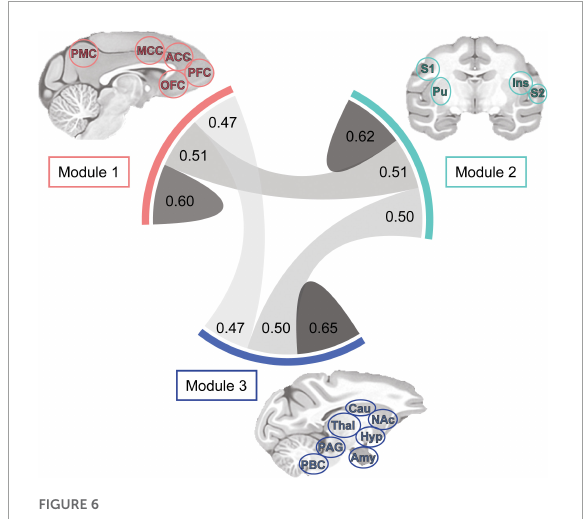
FIGURE6 Tri-modular connectome and connection strength within and between sub-networks. Each module includes a unique set of regions and all modules exhibited bilaterality, indicating inclusion of region nodes in the left and right hemispheres. Chord diagram showing the correlation strength between bilateral regions of Modules 1 ( n = 8), 2 ( n = 12), and 3 ( n = 9). Connection line thickness and darkness represent correlation strength. Note the difference in connection strength ( r -value) between and within Modules: 1-1, 0.60; 1-2, 0.51; 1-3, 0.47; 2-2, 0.62; 2-3, 0.50; 3-3, 0.65. ACC, anterior cingulate cortex; Amy, amygdala; Cau, caudate; Hyp, hypothalamus; Ins, insula; NAc, nucleus accumbens; MCC, mid-cingulate cortex; OFC, orbitofrontal cortex; PAG, periaqueductal gray; PBC, parabrachial complex; PFC, prefrontal cortex; PMC, posterior medial cortex area 7m; Pu, putamen; S1, primary somatosensory cortex; S2, secondary somatosensory cortex; Thal, thalamus.